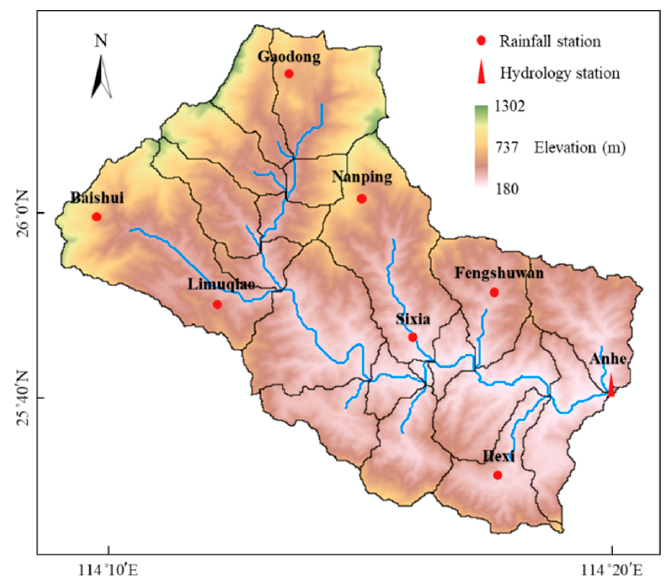
Figure 7. Study catchment with the hydrology station and rain stations.